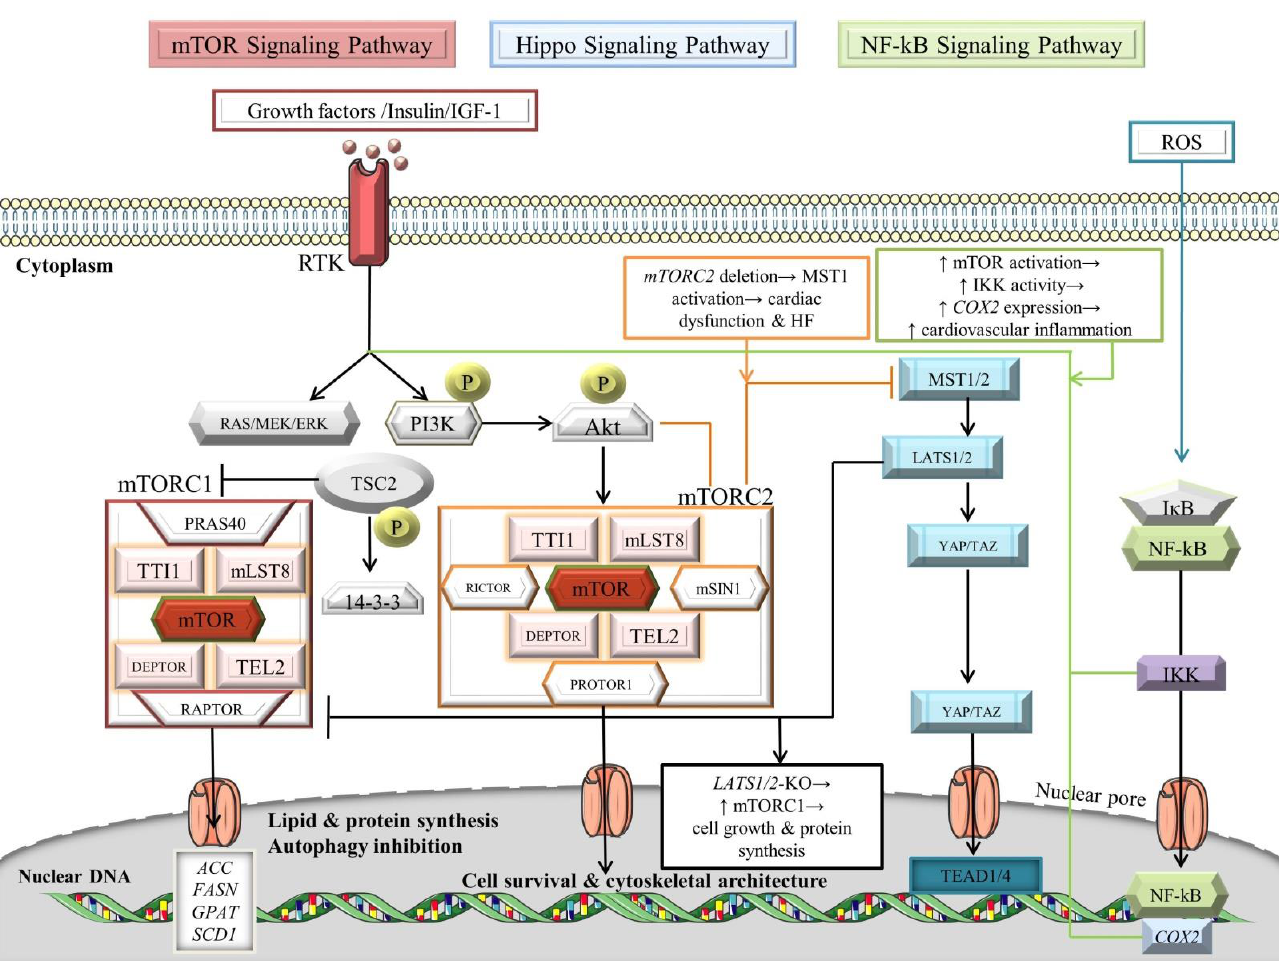
Figure 3. Signaling crosstalk between NF-κB, Hippo, and mTOR pathways. For details, see main text. The black arrows designate central signaling pathways; the continuous arrows denote activation; and the continuous blunt-ended arrows indicate inhibition. ACC: acetyl-CoA carboxylase; Akt: v-akt murine thymoma viral oncogene homolog/Protein kinase B; COX2: cyclooxygenase 2; DEPTOR: DEP domain-containing mTOR-interacting protein; ERK: extracellular signal-regulated kinase; FASN: fatty acid synthase; GPAT: glycerol-3-phosphate acyltransferase; HF: heart failure; IkB: inhibitor of NF-kB; IGF-1: insulin-like growth factor 1; IKK: I κ B kinase; LATS1/2: large tumor